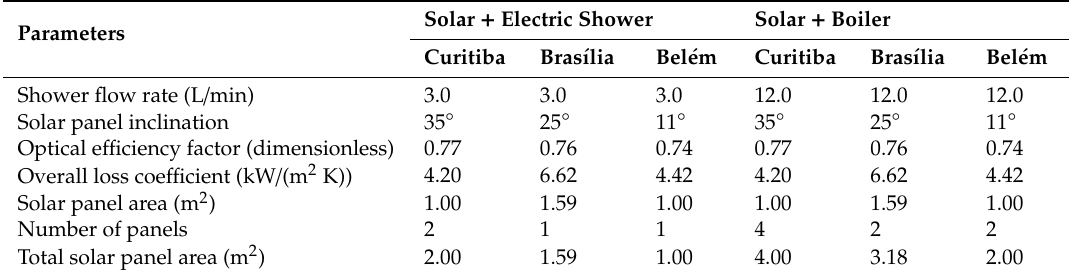
Table 2. Solar water heating systems characteristics.